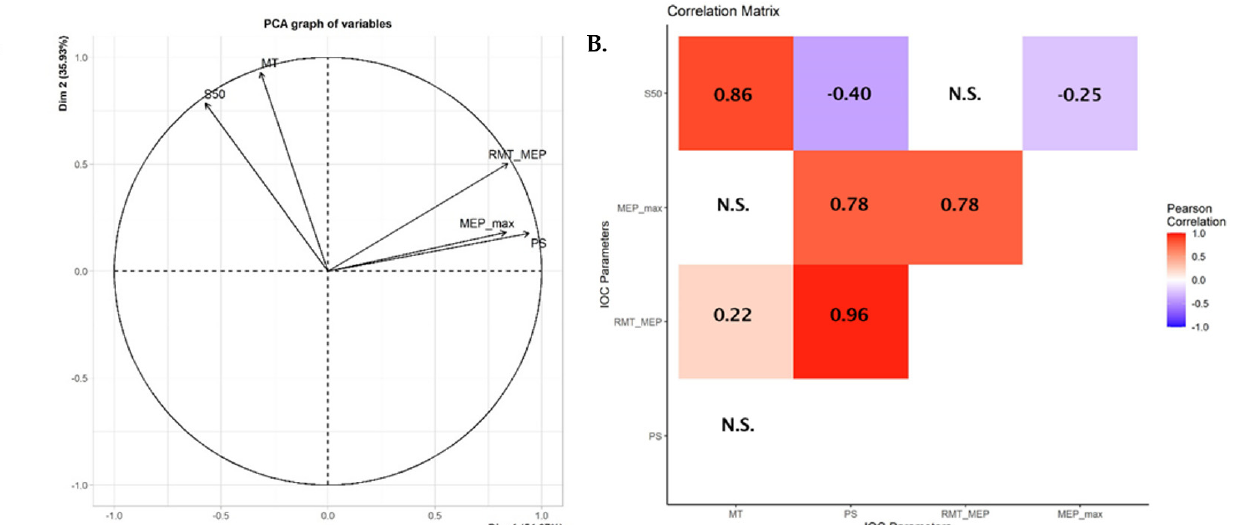
Figure 2. Flowchart of data analysis pipeline. (MEP amp = MEP amplitude at 120% resting motor threshold, GLM = General Linear Model, CV = Coefficient of Variation, RF = Random Forest, IOC = Input–Output Curve.).